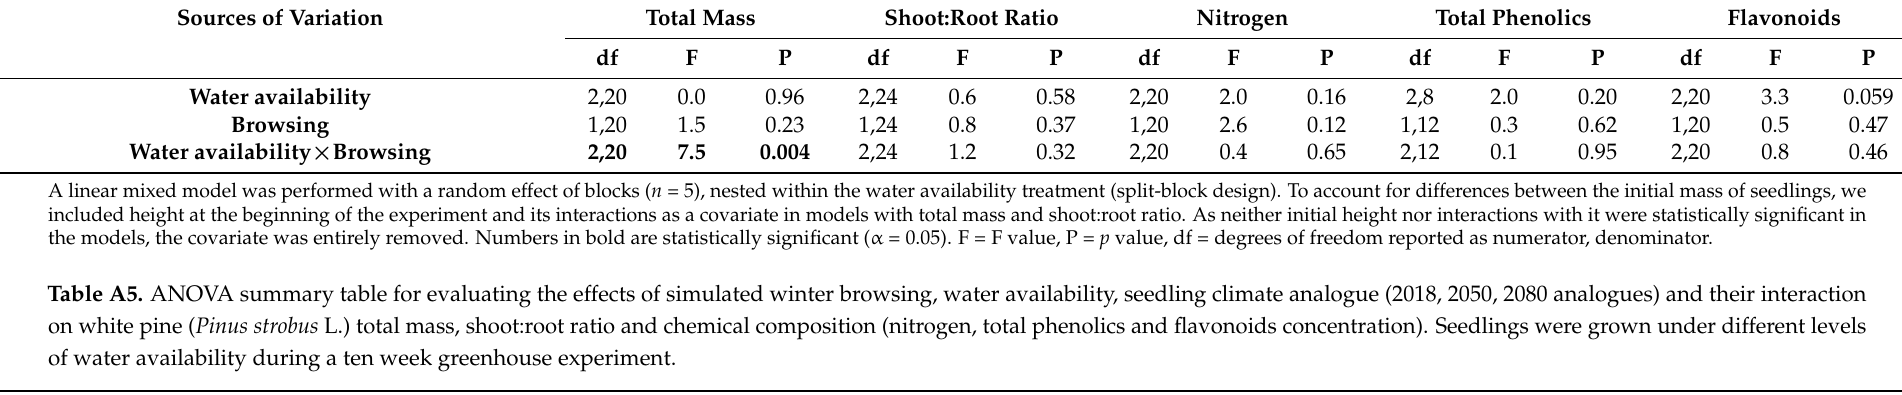
Table A4. ANOVA summary table for evaluating the effects of simulated winter browsing, water availability and their interaction on sugar maple ( Acer saccharum Marsh.) total mass, shoot:root ratio and chemical composition (nitrogen, total phenolics and flavonoids concentration). Seedlings were grown under different levels of water availability during a ten week greenhouse experiment.